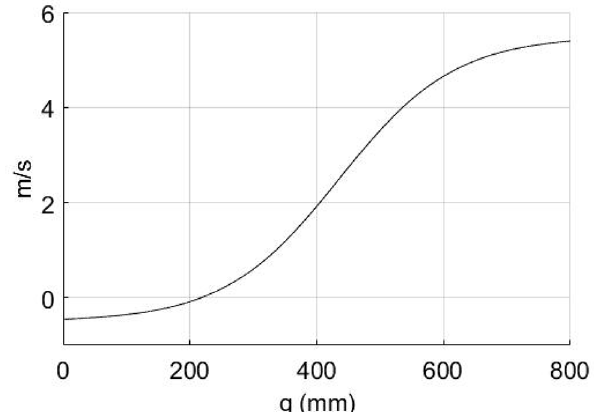
Figure 4 Optimal velocity for